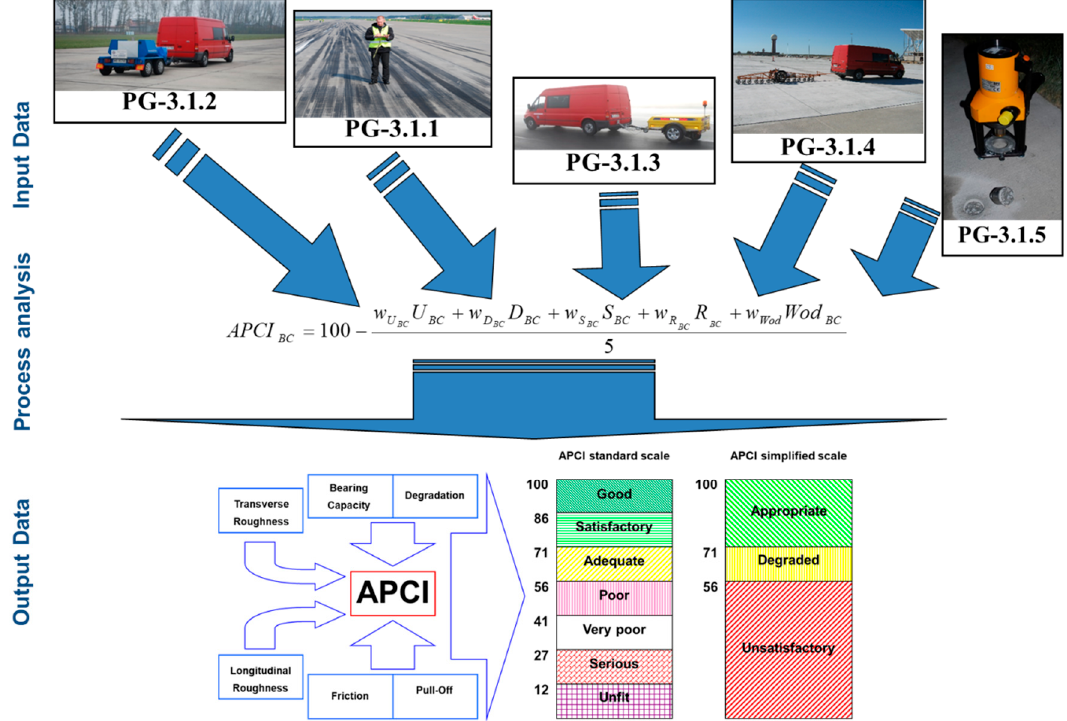
Figure 4. Evaluation of the AFE’s pavement condition.